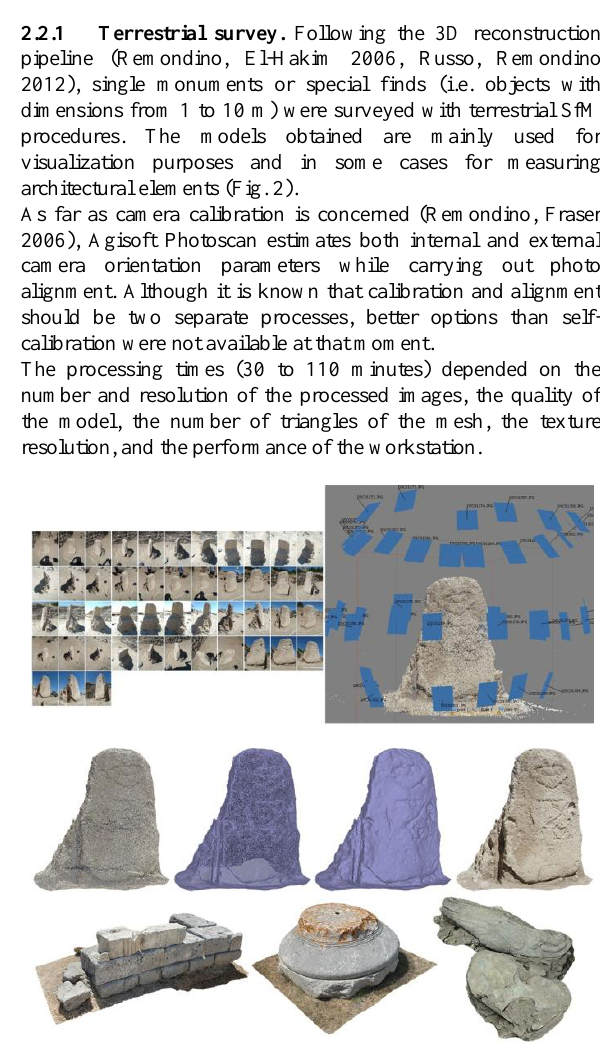
Figure 2. 3D models realized with terrestrial SfM procedures